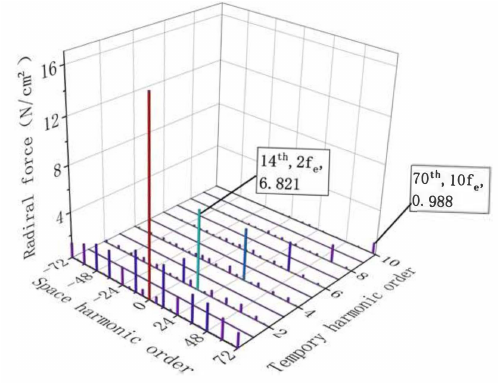
Figure 4. 2DFFT of radial electromagnetic